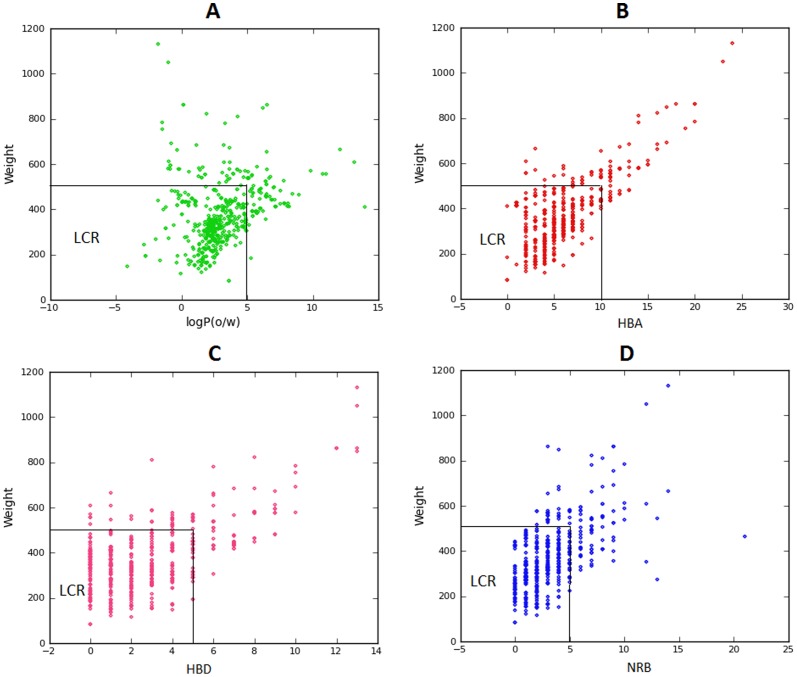
Pair-wise distribution of Lipinski parameters for the p-ANAPL library; (A) log P against MW, (B) HBA against MW, (C) HBD against MW and (D) NRB against MW.